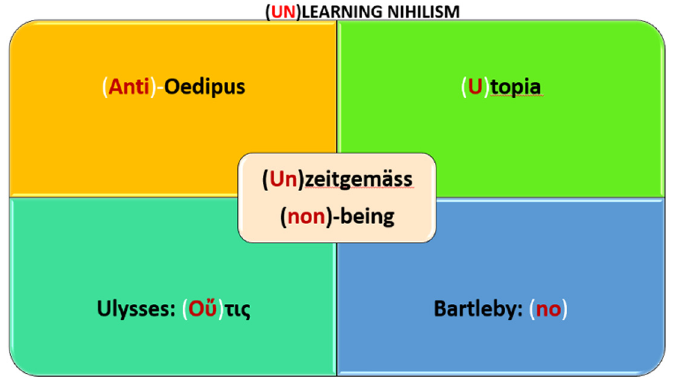
Figure 3: The a ffi rmative [ non -]